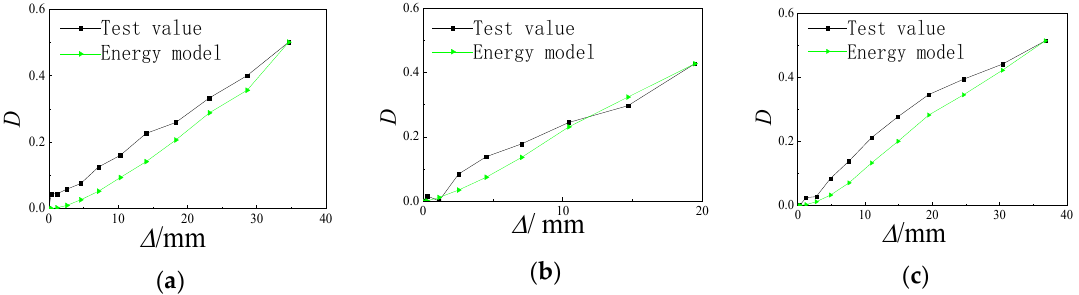
Figure 14. Damage model and test curve comparisons: ( a ) S-4; ( b ) S-5; ( c ) S-6.